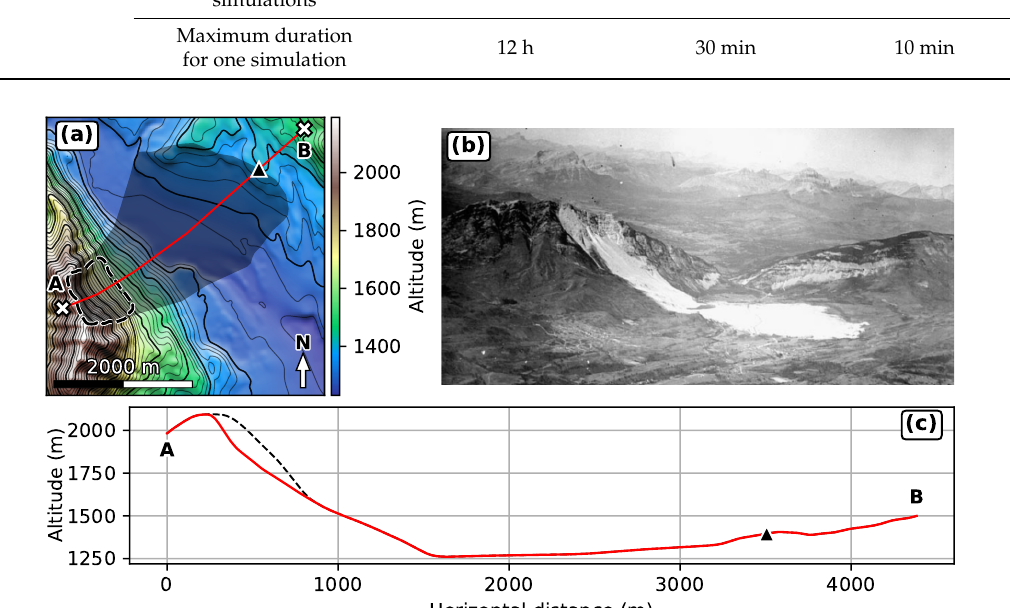
Figure 3. Frank Slide rock avalanche. ( a ) Post collapse topography with deposits removed, 20 m DEM. Black dashed outline: landslide scar. Dark area: observed landslide extent. Bold contour interval is 100 m. Red line: cross-section along which travel distances are measured. Dark triangle: Observed travel distance. ( b ) Picture of the Frank Slide, taken in 1922 (Canada. Dept. of National Defence/Library and Archives Canada/PA-052095). ( c ) Cross-section along red line in ( a ). Red line: Post-collapse topography with deposits removed. Black dashed line: Reconstructed pre-collapse topography. Black triangle: observed deposit